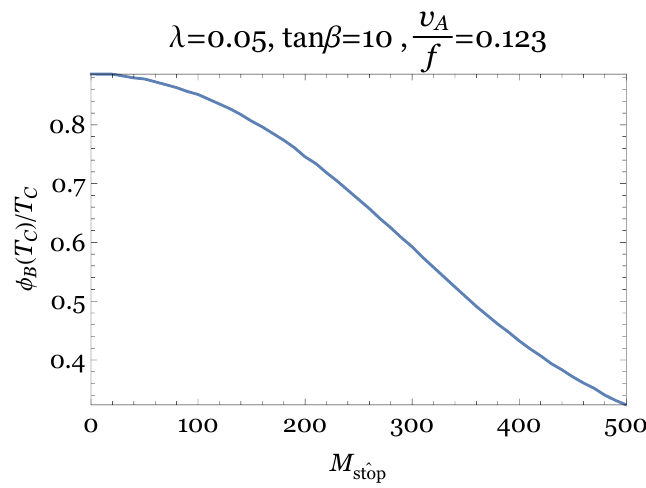
Figure 4 . This graph shows (cid:30) set some physical parameters as (cid:21) = 0 : 05 ;